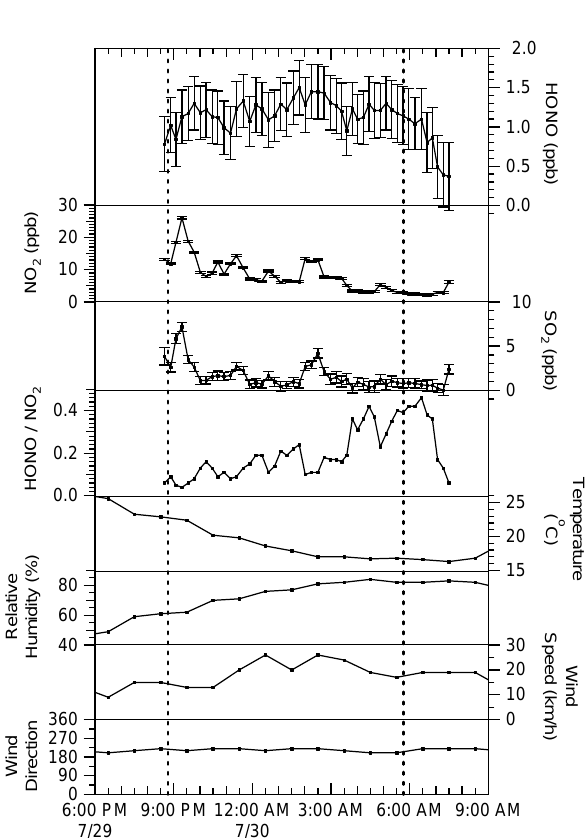
Fig. 4. Nocturnal measurements 29/30 July at East Point, Saturna Island. Vertical dashed lines represent times of sunset and sunrise.